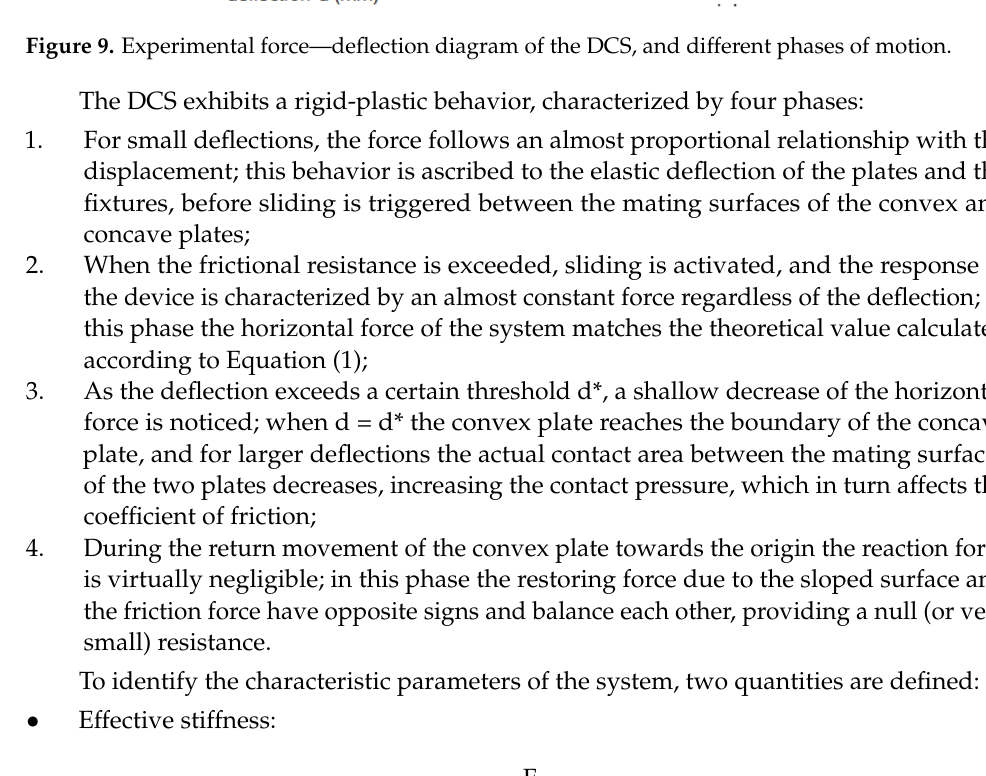
Figure 9. Experimental force—deflection diagram of the DCS, and different phases of motion.